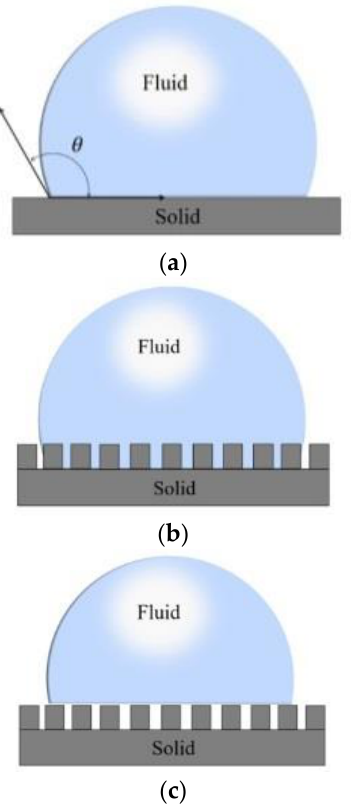
Figure 3. Different wettability models; ( a ) the Young model; ( b ) the Wenzel model; ( c ) the Cassie model.